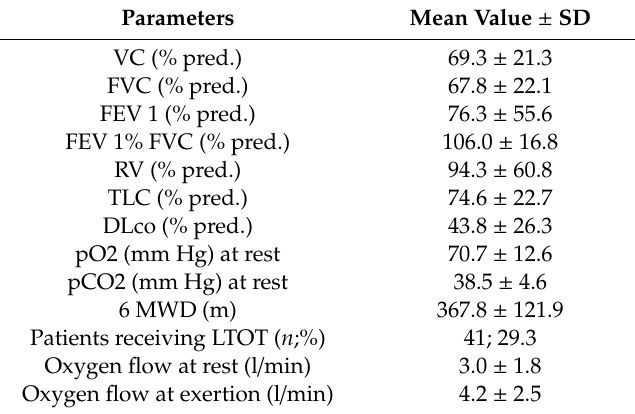
Table 2. Results of lung function and gas exchange data in the uILD